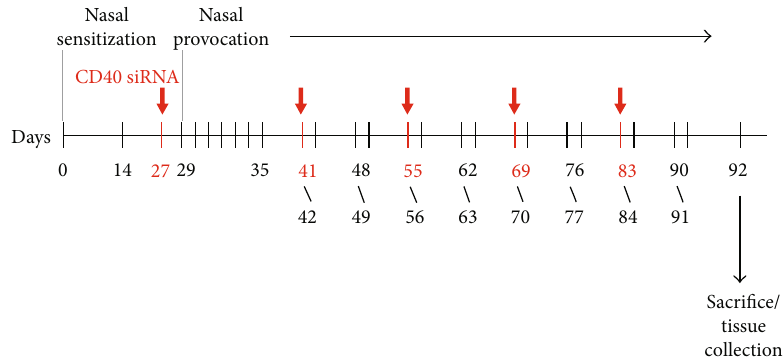
Figure 1: Mouse model of chronic AR and CD40 siRNA